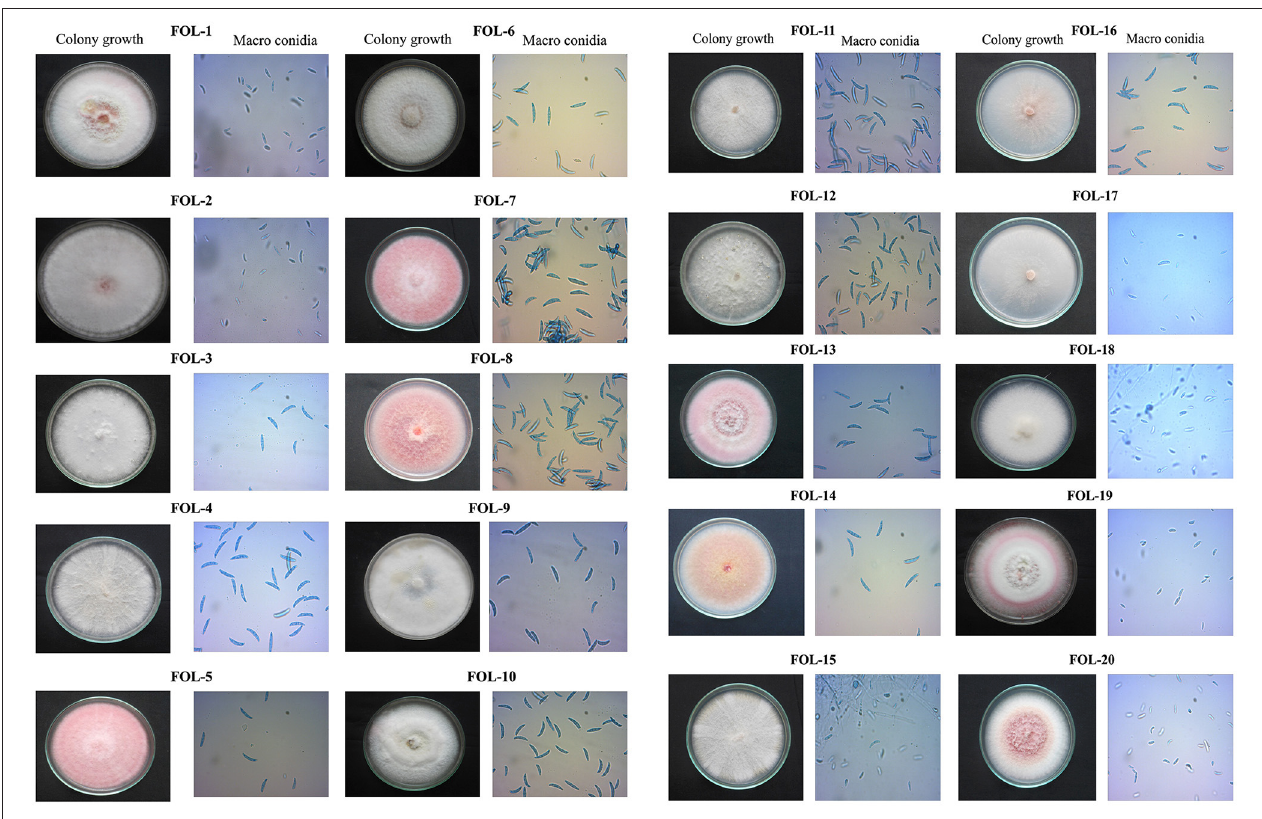
FIGURE 1 | Cultural and morphological characters of F. oxysporum f.sp. lycopersici .